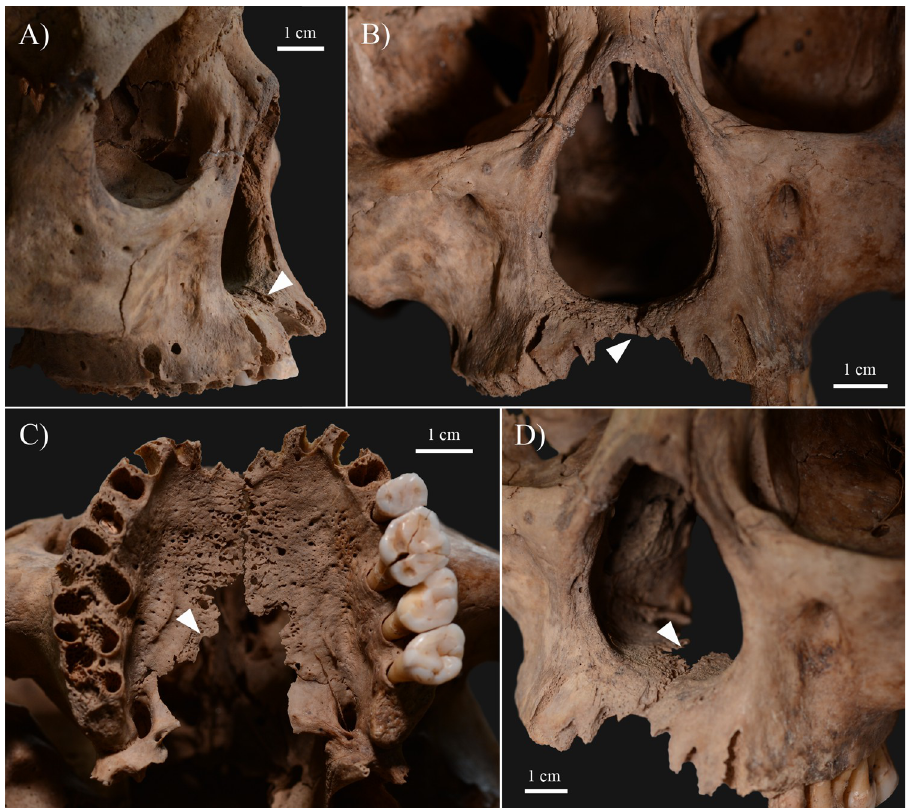
Fig 4. Rhinomaxillary lesions in the skull of KK61. A) Resorption of the anterior nasal spine (white arrow) and the left inferior nasal concha, and widening and rounding of the inferior half of the pyriform aperture (left side); B) Resorption of the anterior nasal spine, the bony nasal septum, the inferior nasal conchae, and the maxillary alveolar process (at the prosthion–white arrow), and widening and rounding of the inferior half of the pyriform aperture; C) Resorption of the maxillary alveolar process (at the prosthion) and pitting, erosion, and perforation (white arrow) on the oral surface of the maxillary palatine process; and D) Resorption of the anterior nasal spine, the bony nasal septum, the right inferior nasal concha, and the maxillary alveolar process (at the prosthion), widening and rounding of the inferior half of the pyriform aperture, and pitting, erosion, and perforation (white arrow) on the nasal surface of the maxillary palatine process.